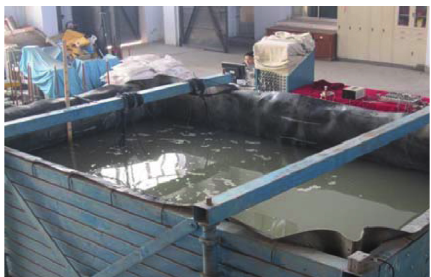
Figure 2: Test 2 model physical